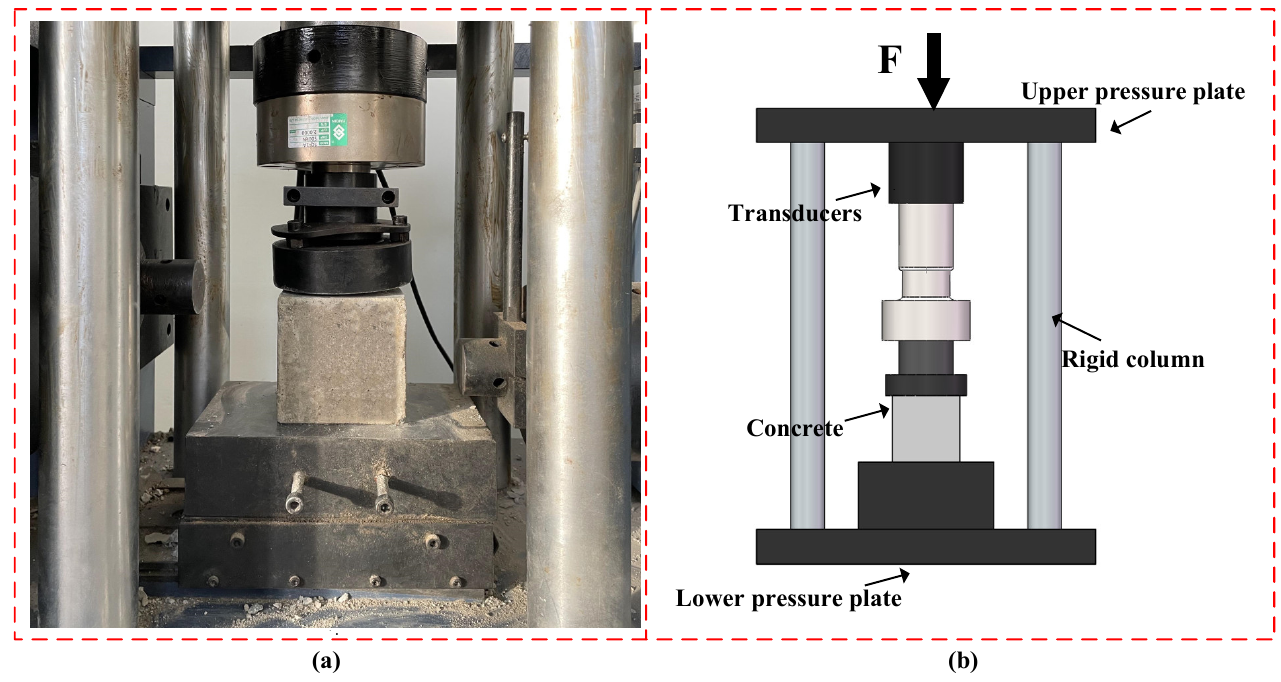
Figure 2. Specimen test device: ( a ) Setting of test; ( b ) Testing apparatus.